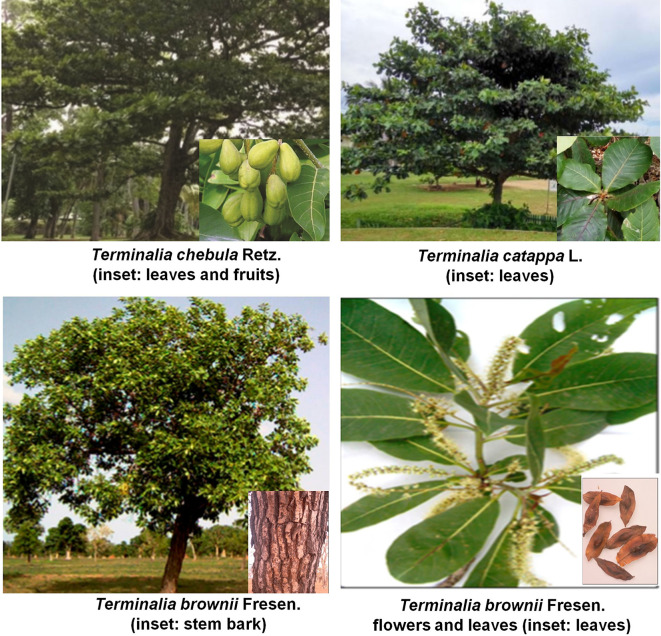
Some of the common Terminalia sp. Reproduced under the Creative Commons Attribution License (Afshari et al., 2016; Marjenah and Putri, 2017; Salih et al., 2017).